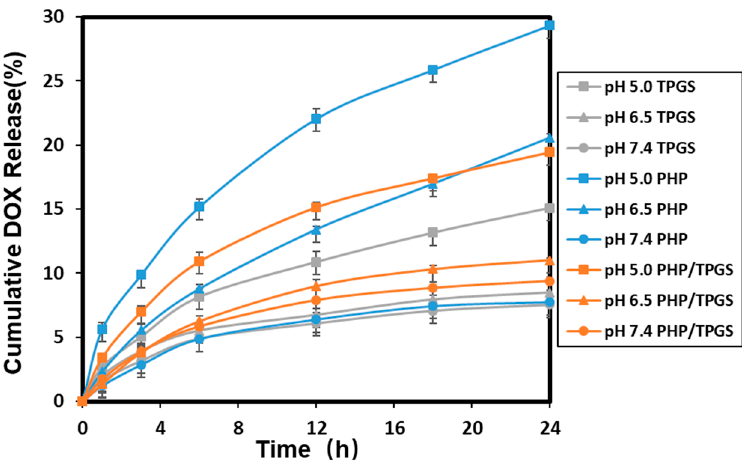
Figure 4. DOX release from PHP micelles, TPGS and PHP/TPGS amphiphilic copolymer micelles at different pH (mean ± SD, n = 3).